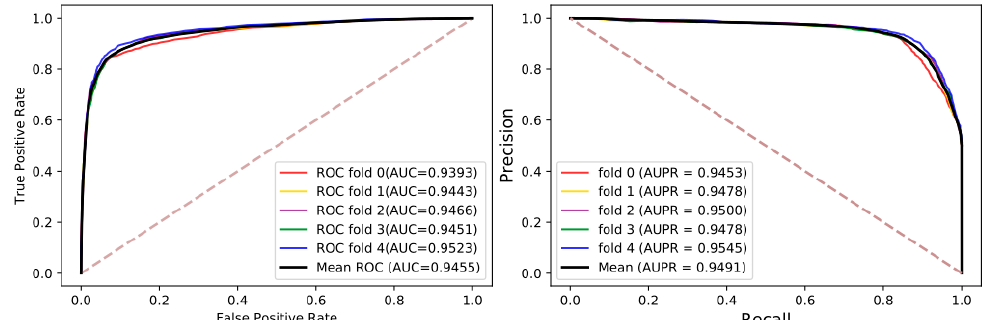
Figure 4. The receiver operating characteristic (ROC) and precision-recall (PR) curves under 5-fold cross-validation.